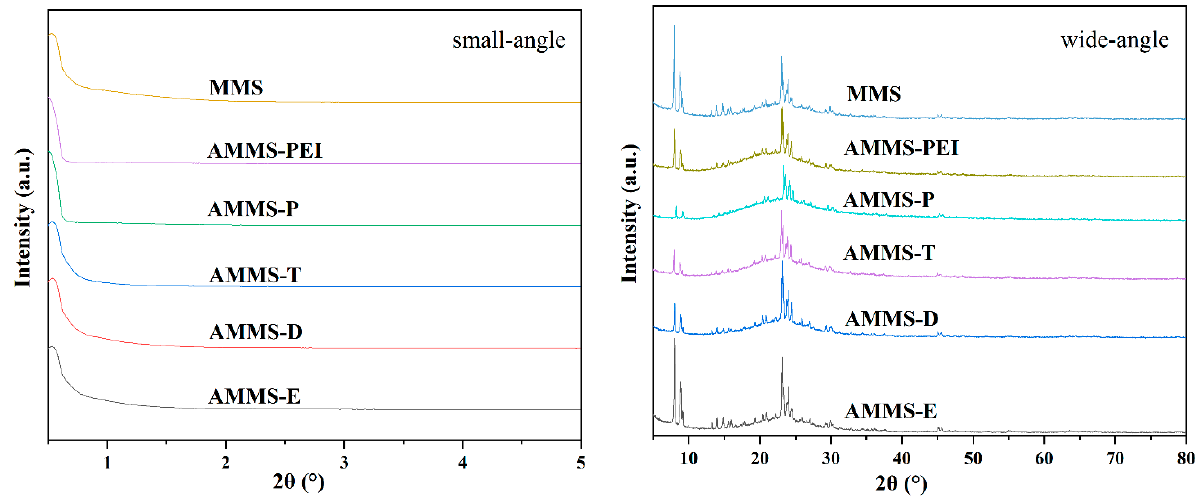
Figure 1. XRD patterns of MMS and